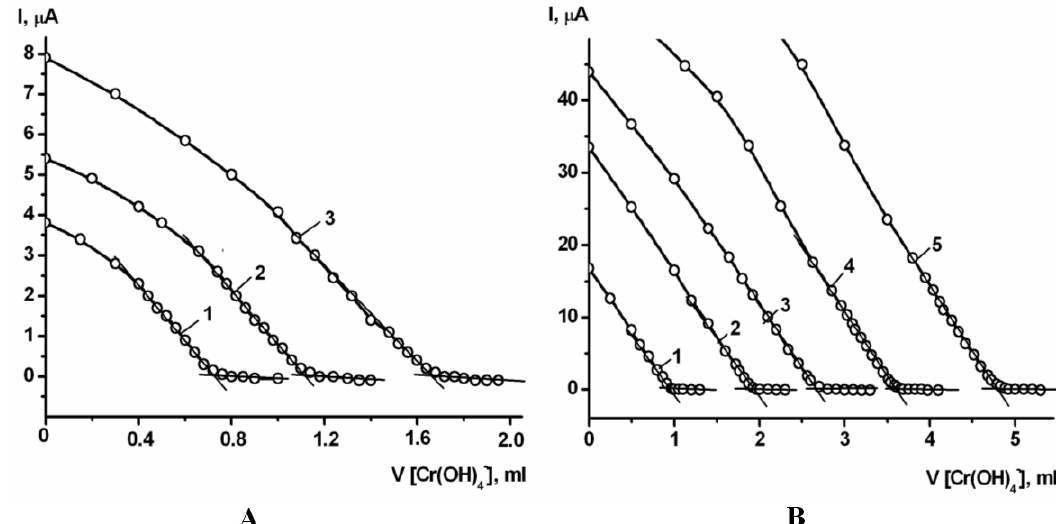
Figure 4. Amperometric titration curves of 10 ml at different concentrations of FeO 42- ions ([NaOH] =15.0 M; 20ºC; Е = -0.2 V). A: 1 – 7.06×10 -5 М ; 2 – 1.07×10 -4 М ; 3 – 1.60×10 -4 М . [Cr(OH) 4- ] = 9.62×10 -4 M B: 1 – 3.44×10 -4 М ; 2 – 7.20×10 -4 М ; 3 – 1.01×10 -3 М Table 2. Comparison of results obtained using chromite and amperometric methods in different concentrations of NaOH (n = 5, p = 0.95). Chomite method [8] [NaOH], М